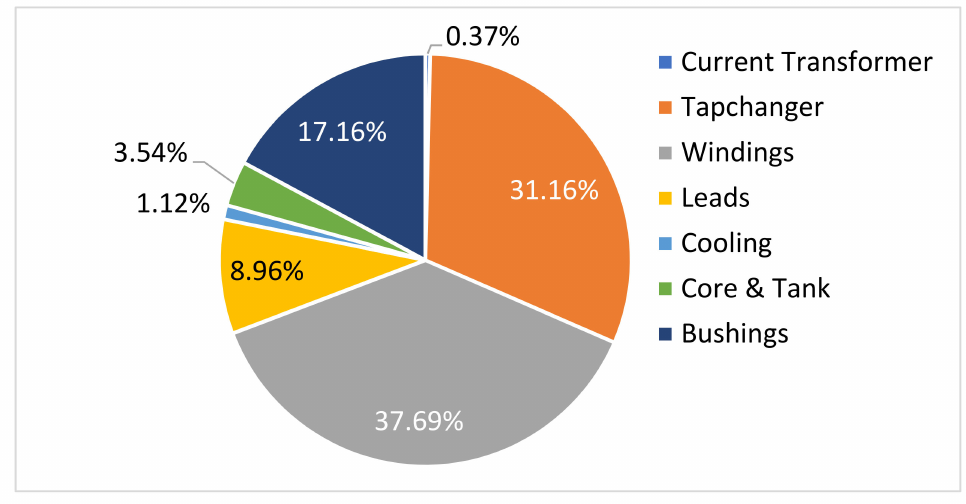
Figure 1. Failure location of substation above 100